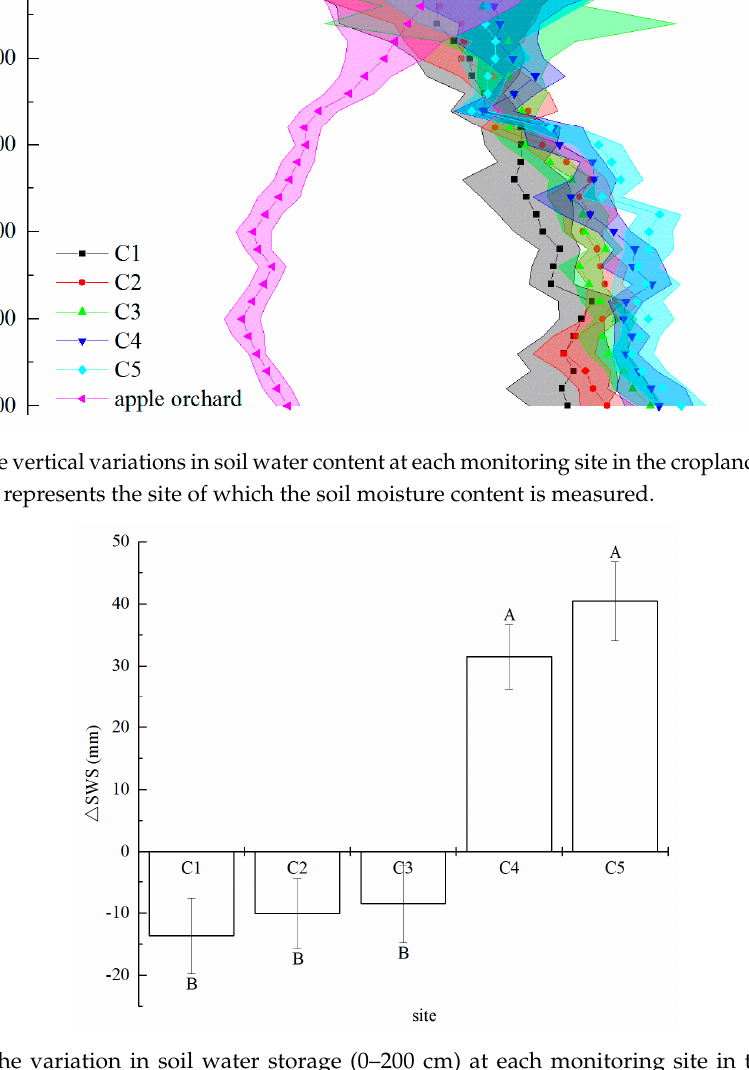
Figure 6. The vertical variations in soil water content at each monitoring site in the cropland. The legend in the figure represents the site of which the soil moisture content is measured.